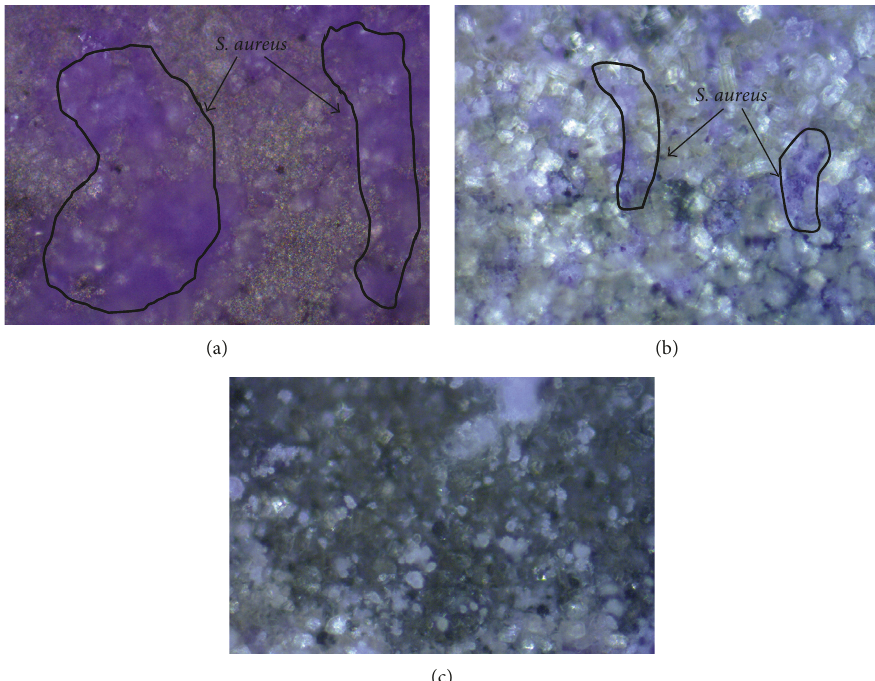
Figure 3: Microbiological adhesion in in vitro tests before and after MAO. (a) Uncoated base material, (b) samples coated in electrolyte A, and (c) samples coated in electrolyte B.